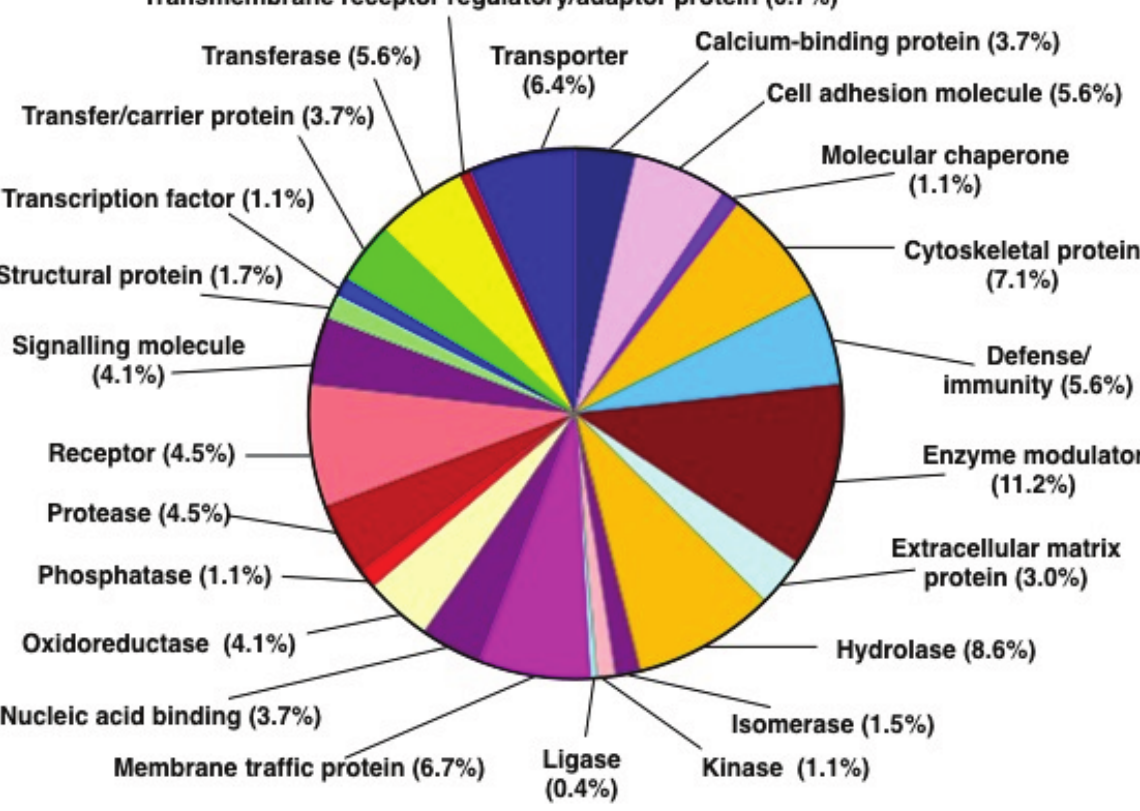
Figure 5. Summary of changed protein classes with an increased abundance in mdx-4cv